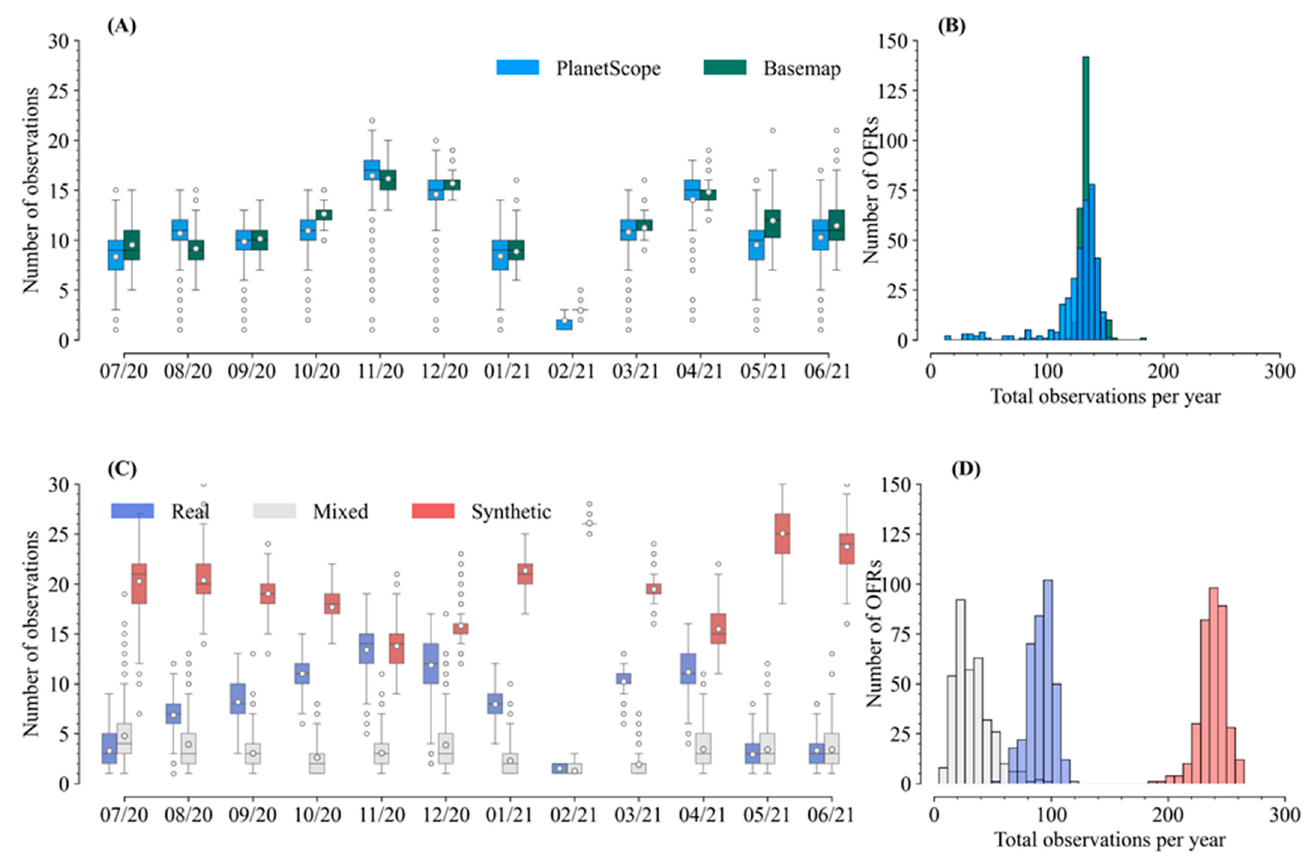
Figure 4. Number of surface area observations per month for PlanetScope and Basemap ( A ) and for Planet Fusion real, mixed, and synthetic ( C ). Frequency distribution of the total number of observations per OFR per year for PlanetScope and Basemap ( B ) and for Planet Fusion real, mixed, and synthetic ( D ).